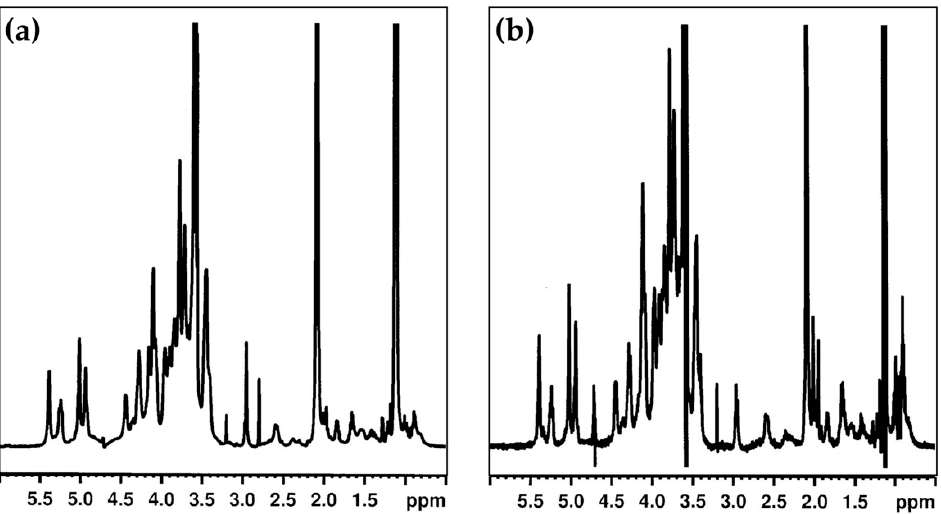
Figure 3. 1 H NMR spectra of EPS extracted from S. plymuthica strain SC3I(2) ( a ) and S. plymuthica strain As3-5a(5) ( b ) in D 2 O, pH 5.1, T = 25 °C.